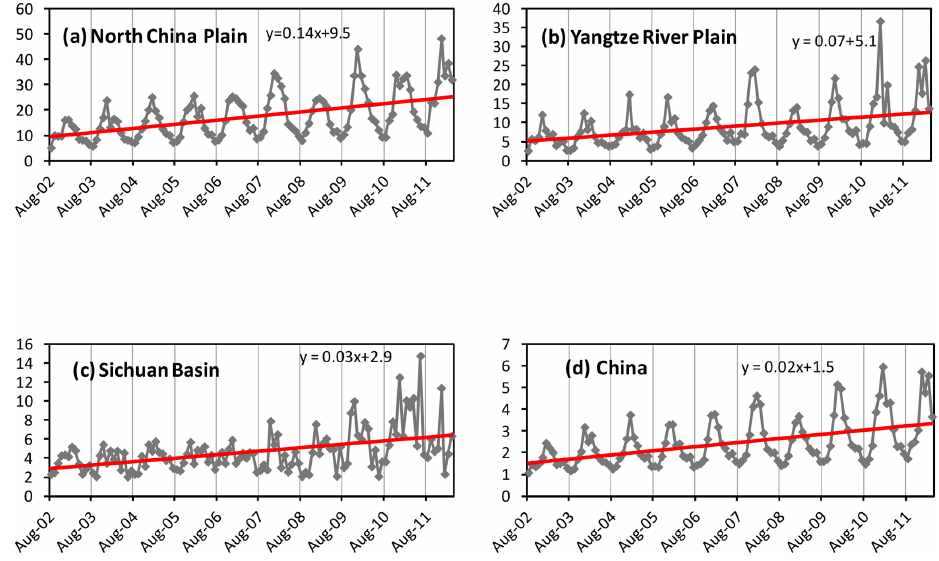
Figure 3. Trends of NO 2 concentration over China from SCIAMACHY for the years 2002–2012 (10 15 molcm − 2